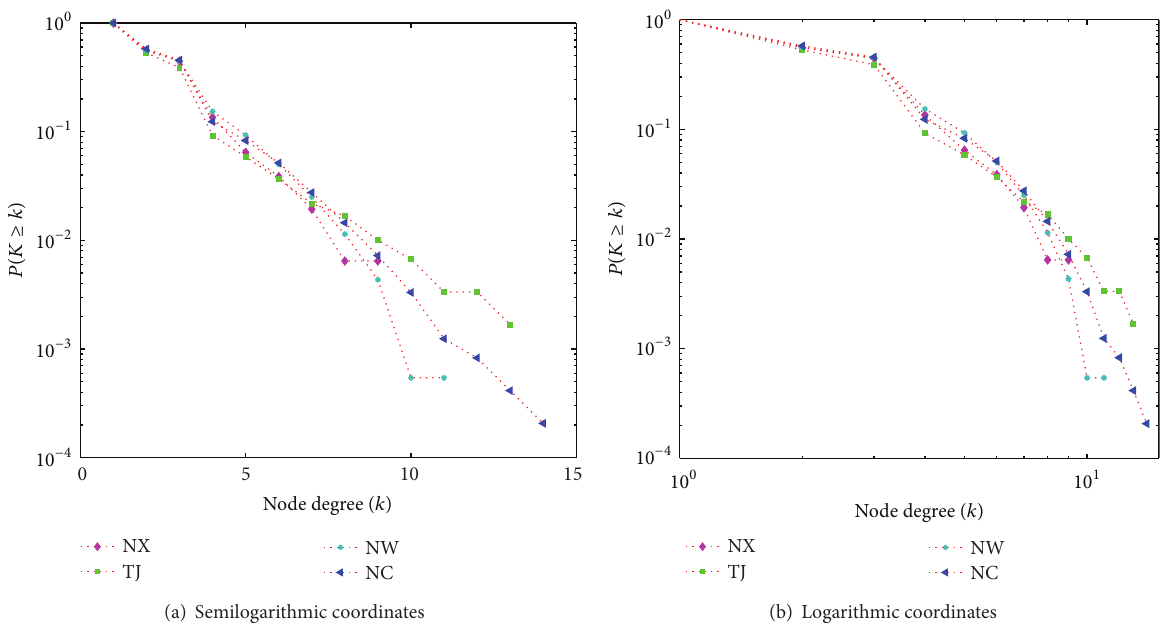
Figure 1: Cumulative degree distribution of topology-based model of power grids.